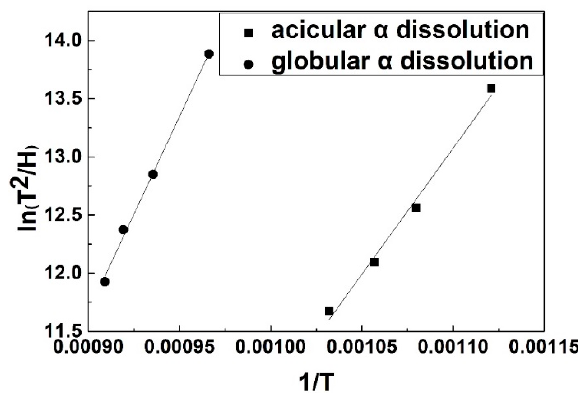
Figure 8. The plot of activation energy for globular and acicular α dissolution in bimodal Ti55531